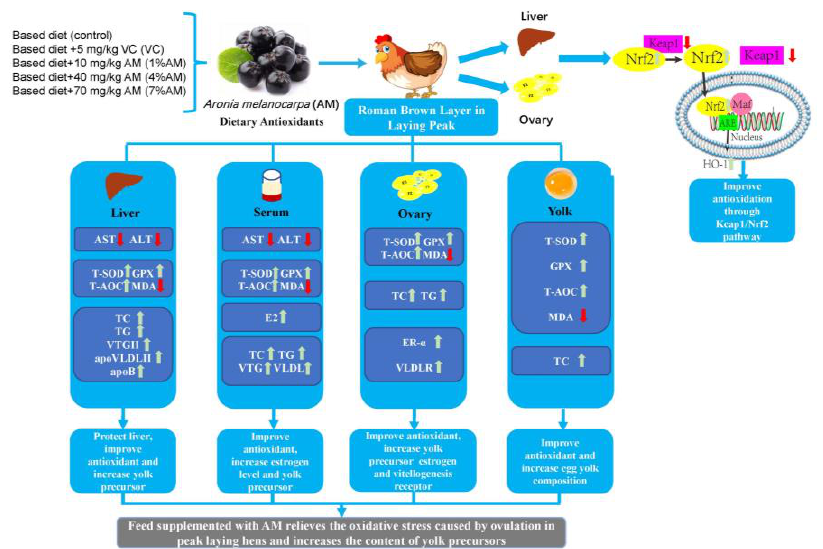
Figure 8. Feed supplemented with AM relieves the oxidative stress caused by ovulation in peak laying hens and increases the content of yolk precursors. ↑ means rise; ↓ means reduce.